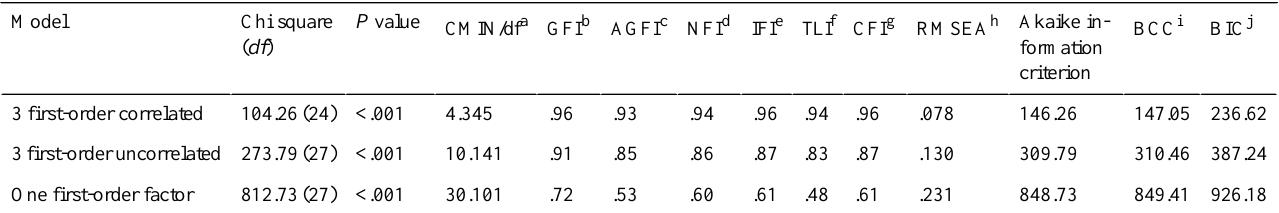
Table 3. Confirmatory factor analysis alternative model testing.